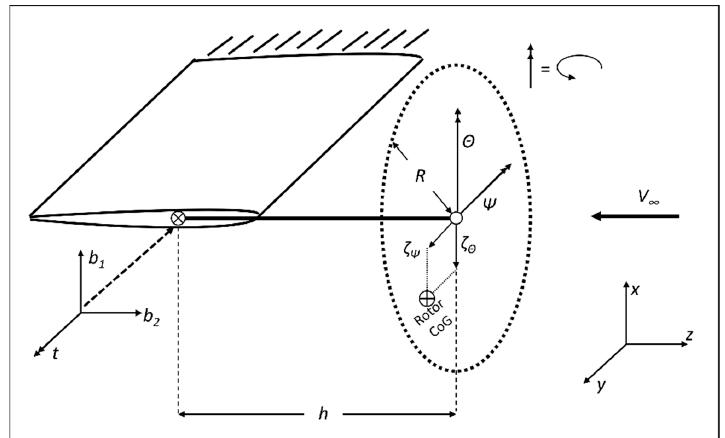
Figure 4 . Gimballed hub model schematic. Figure 4. Gimballed hub model